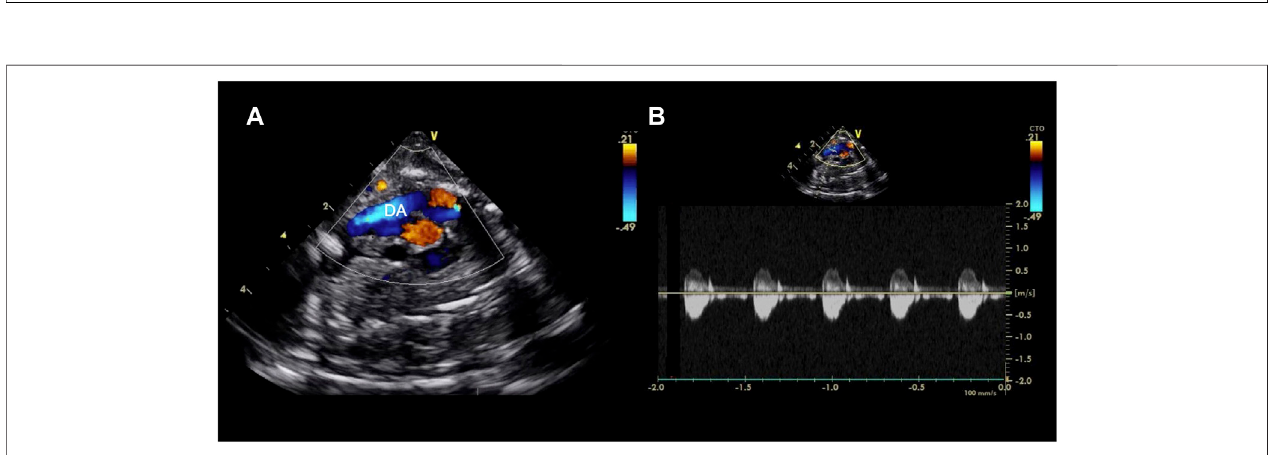
FIGURE4| Echocardiographicaxialmediastinalimageofafetalpigmaintainedusingapumped APcircuit,demonstratingtheductusarteriosus(DA)widelypatent (A) and with a normal low velocity fl ow pro fi le as shown on the pulsed wave doppler (B) . A video can be found in the Supplementary Material .